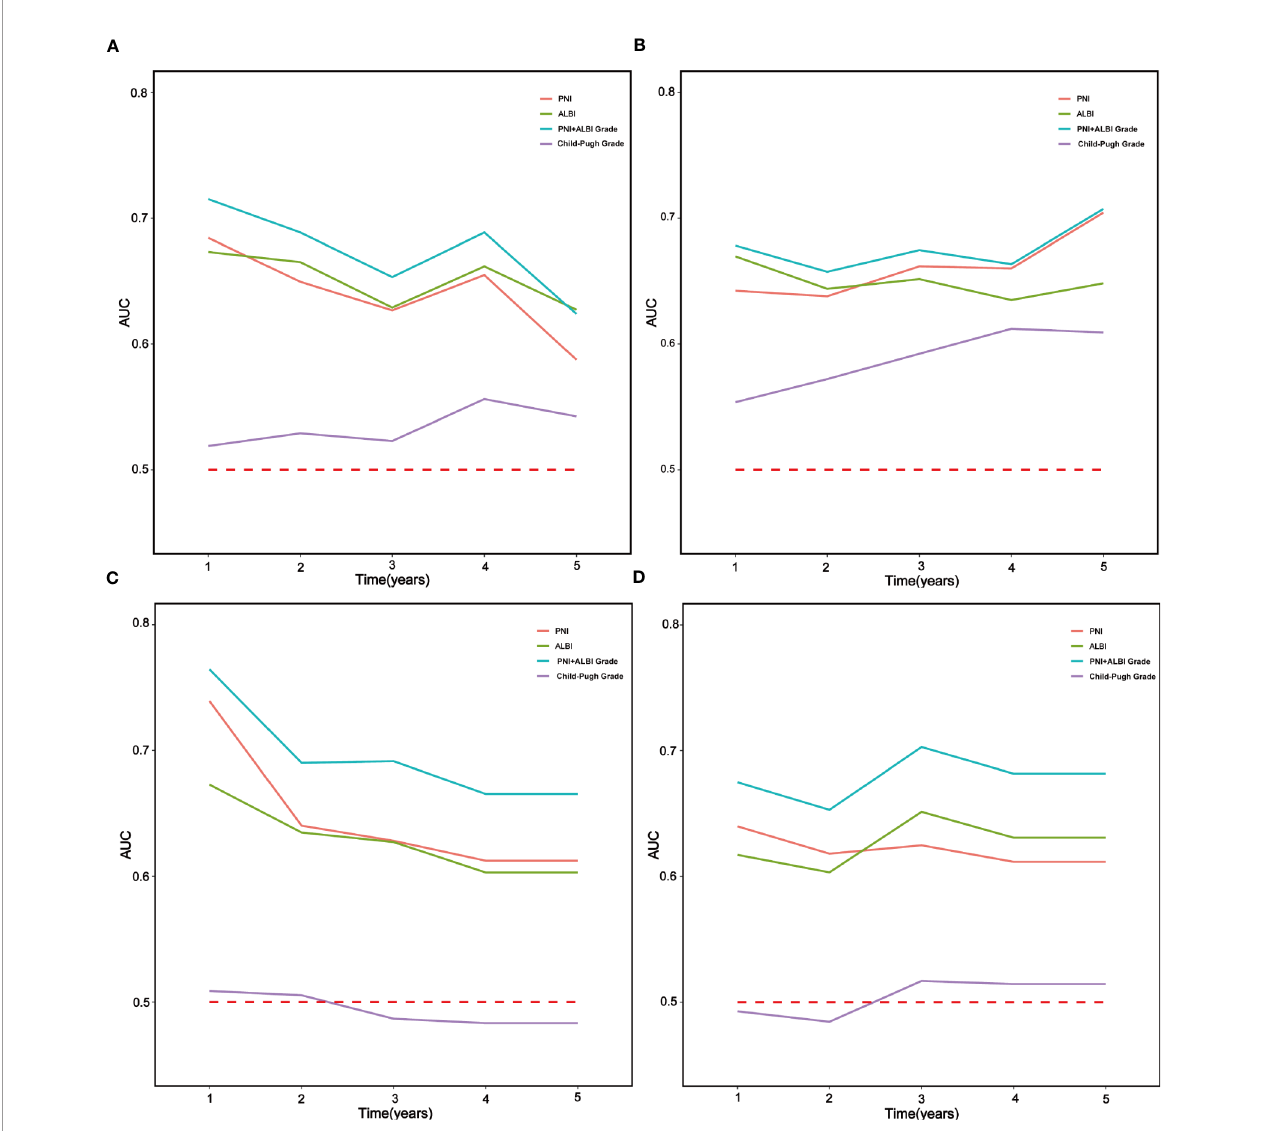
FIGURE 3 | Time-dependent receiver operating characteristic (time-ROC) curves for overall survival (OS) and recurrence-free survival (RFS) of patients with intrahepatic cholangiocarcinoma (ICC) after radical resection. The horizontal axis shows the months after surgery and the vertical axis the estimated area under the ROC curve (AUC) for survival at the time of interest. Blue , green , red , and purple solid lines denote the estimated AUCs for the prognostic nutritional index (PNI) plus ALBI grade, ALBI, PNI, and Child – Pugh grade, respectively. (A, C) Time-ROC curves for OS in the training and testing sets, respectively. (B, D) Time-ROC curves for RFS in the training and testing sets,